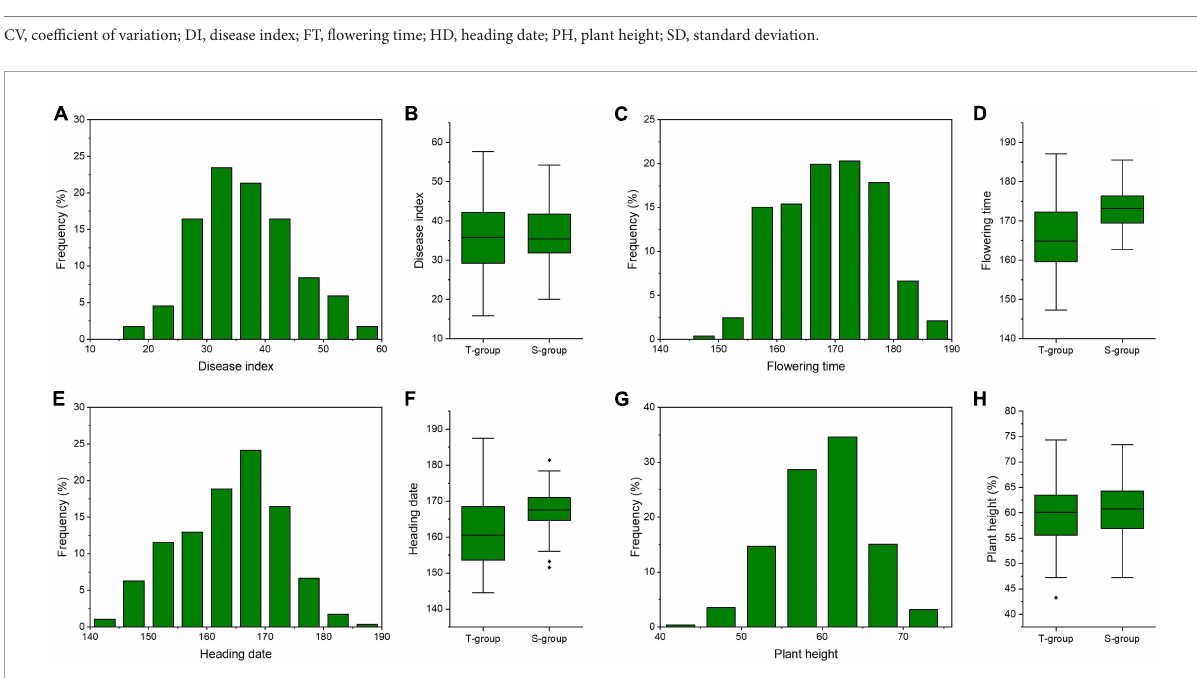
FIGURE2 Phenotypic distributions of phenotypic traits among the whole population and subgroups. Frequency distributions of disease index (A) , flowering time (C) , heading time (E) , and plant height (G) among 286 Aegilops tauschii accessions. Box plots of disease index (B) , flowering time (D) , heading time (F) , and plant height (H) among two subgroups. S-group and T-group represent the Aegilops tauschii ssp. strangulata group and the Aegilops tauschii ssp. tauschii group,